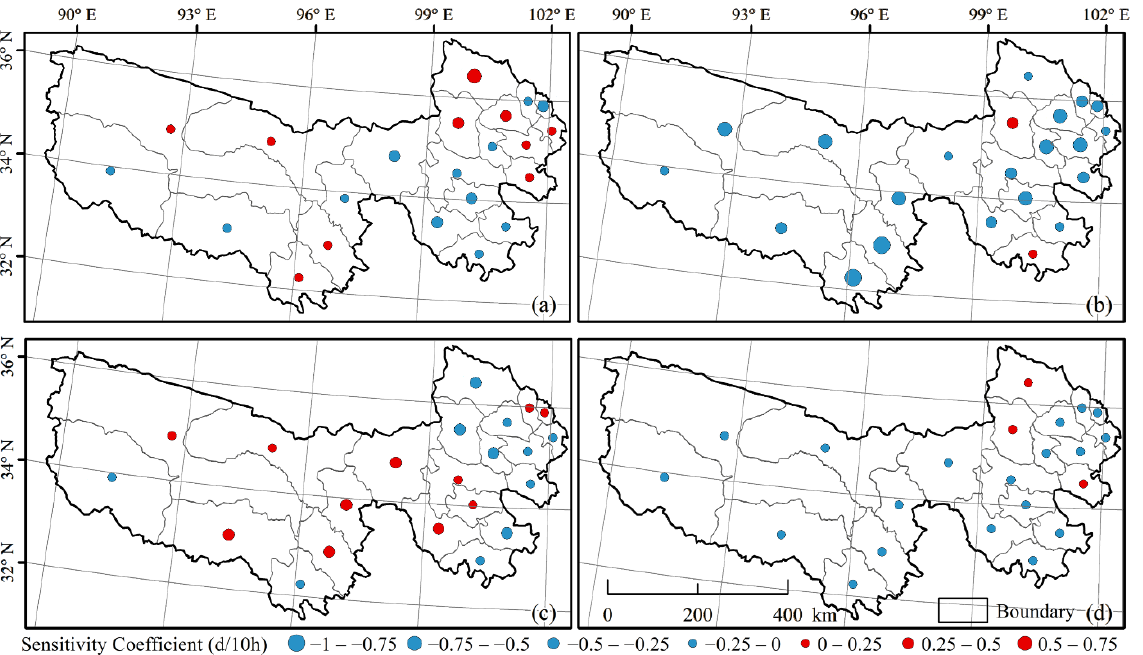
Figure 13. Spatial distribution of the sensitivity coefficients between the SOS of the vegetation and sunshine duration in March ( a ), April ( b ), May ( c ) and March – May ( d ) in the Three-River headwaters region. Table 3. Statistics on the correlation between the SOS of the vegetation and meteorological factors in different time periods (%).